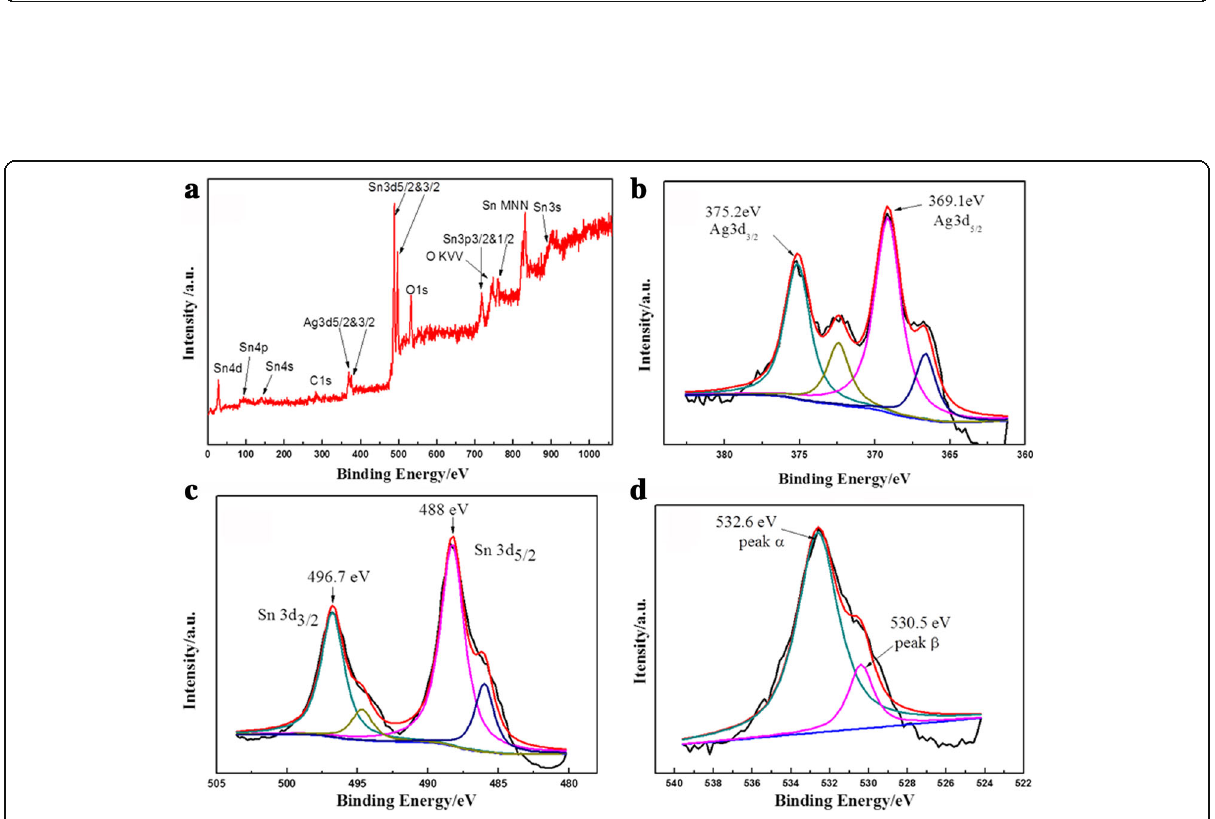
Fig. 4 Typical nitrogen adsorption – desorption isotherm of the prepared SnO 2 /Ag microspheres prepared at 150 °C for different hydrothermal times a 5 h, b 10 h, c 24 h, and d 36